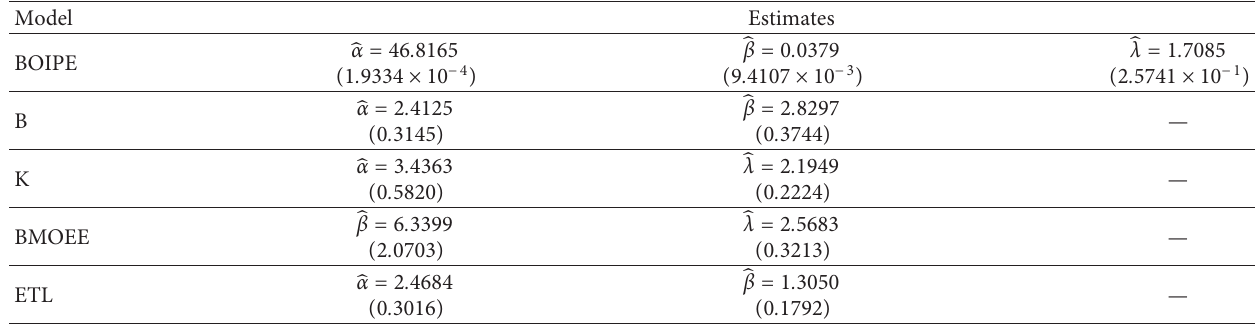
Table 4: Maximum likelihood estimates for data I.